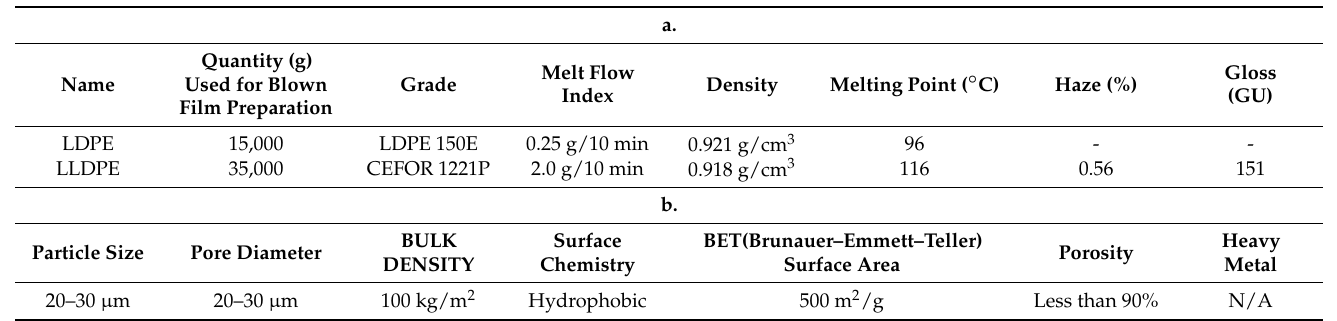
Table 1. ( a ). The material properties of the low-density polyethylene (LDPE)/linear low-density polyethylene samples. ( b ). The technical data of the silica aerogel (SA). a.